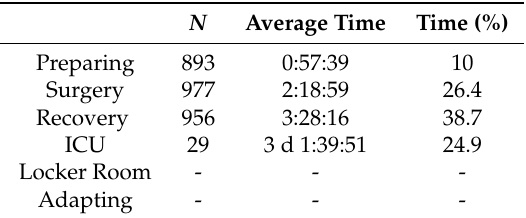
Table 3. Post-hospitalized patients states.